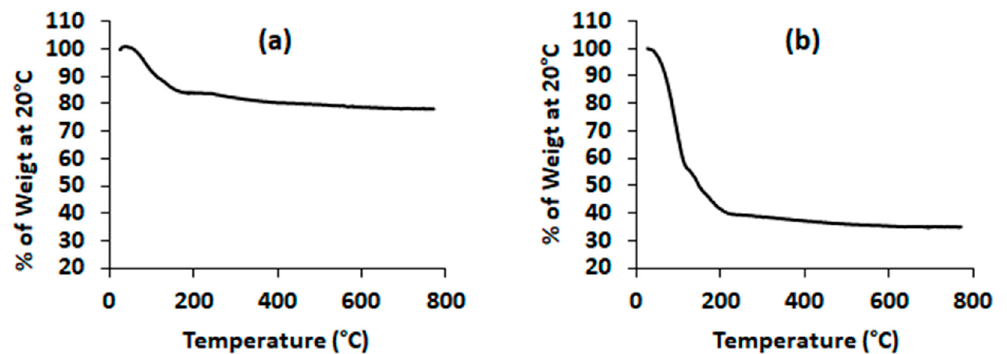
Figure 3. Thermogravimetric analysis (TGA) of MSPs: ( a ) empty mesoporous silica particles, ( b ) AP-EO/MSPs, mesoporous silica particles loaded with A. pusilla essential oil.